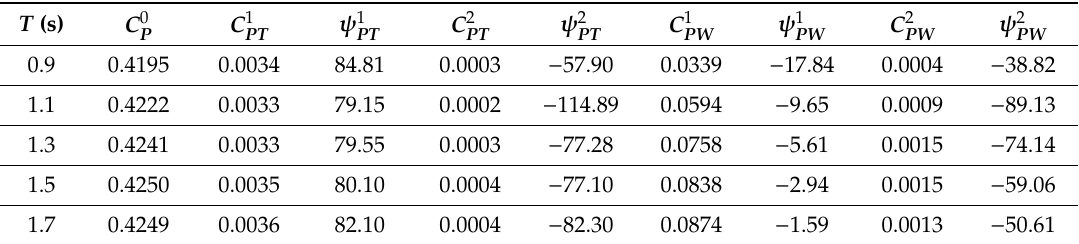
Table 5. Expansion coe ffi cient table of energy utilization ratio under the di ff erent wave periods.